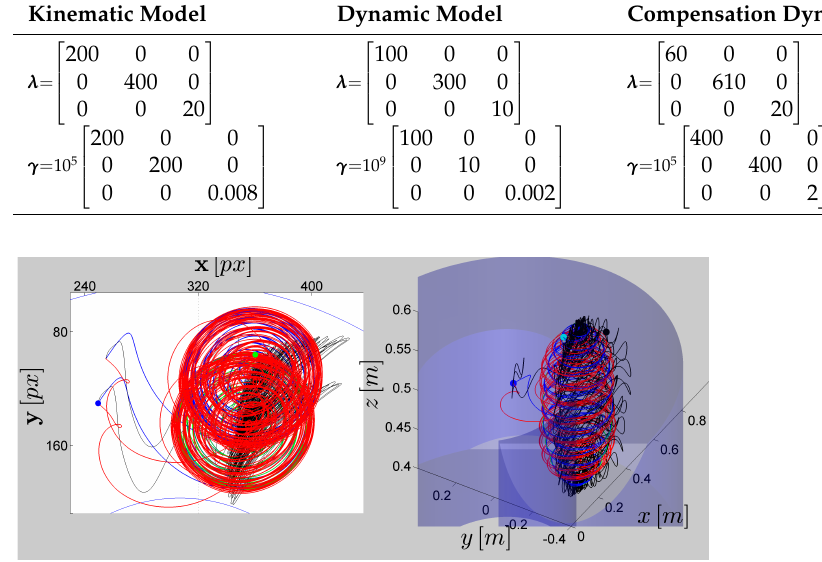
Figure 6. The image features for the following